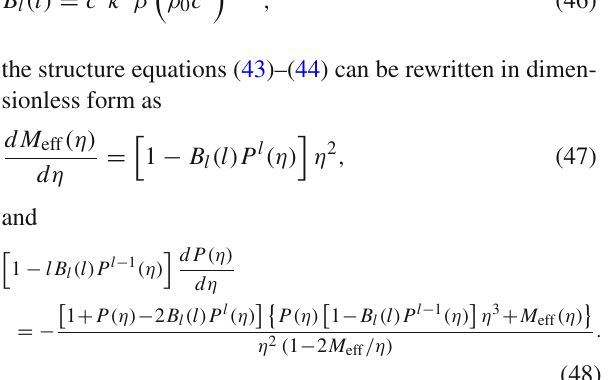
smaller value, η S ≈ 1 . 02. This value is not very sensitive to the assumed values of the parameter B 2 . However, when looking at the behaviour of the solution near the vanishing pressure surface, some difference are clear, as one can see from Fig. 2. Hence, the radius of the star with the torsion effects taken into account is of the order of R ≈ 10 . 57 × (cid:10) (cid:11) − 1 / 2 / 10 15 g / cm 3 ρ km, while for the standard general- 0 (cid:11) (cid:10) − 1 / 2 / 10 15 g / cm 3 ρ relativistic star we have R ≈ 10 . 98 × 0 km. This represents a discrepancy of less than 5%. The same effect can be seen in the numerical values of the masses of the stars. While for the general-relativistic case M eff is of the order of M eff ≈ 0 . 38, for stars in Einstein– Cartan theory M eff has a slightly smaller value of order M eff ≈ 0 . 36, which gives the corresponding masses val- (cid:11) (cid:10) − 1 / 2 / 10 15 g / cm 3 ρ M (cid:14) and ues of order M ≈ 2 . 65 × 0 (cid:11) (cid:10) − 1 / 2 / 10 15 g / cm 3 ρ M (cid:14) , respectively. This M ≈ 2 . 52 × 0 corresponds to roughly a 5% change in the mass due to tor- rion. A good knowledge of the equation of state of dense neutron matter, associated with high precision astronomical observations, may therefore lead to the possibility of discrim- inating Einstein–Cartan theory from general relativity in the study of compact astrophysical